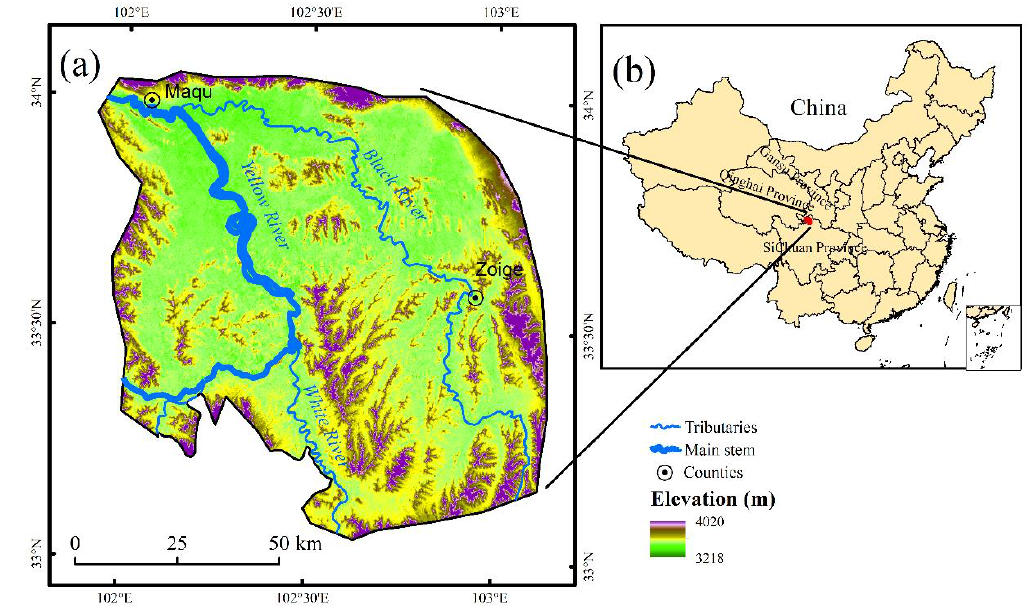
Figure 1. Location and physiography of the study area. ( a ) Physiography, ( b ) Location.